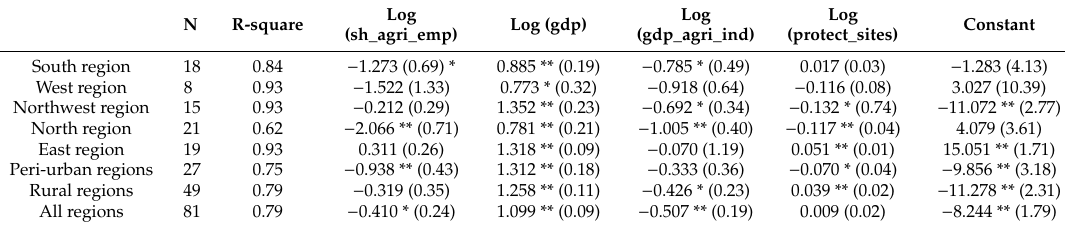
Table9. Resultsoftheregressionanalysisexplainingdevelopmentofindustriallandfordi ff erentregions. N R-square